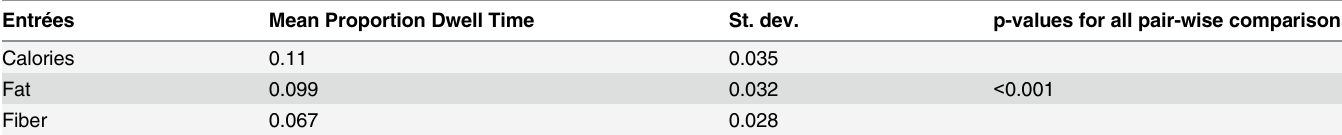
Table 3. Average proportion dwell times by Front-of-Package nutrition types for entrées. P-values are Tukey-Kramer adjusted for multiple comparisons. Entrées Mean Proportion Dwell Time St.